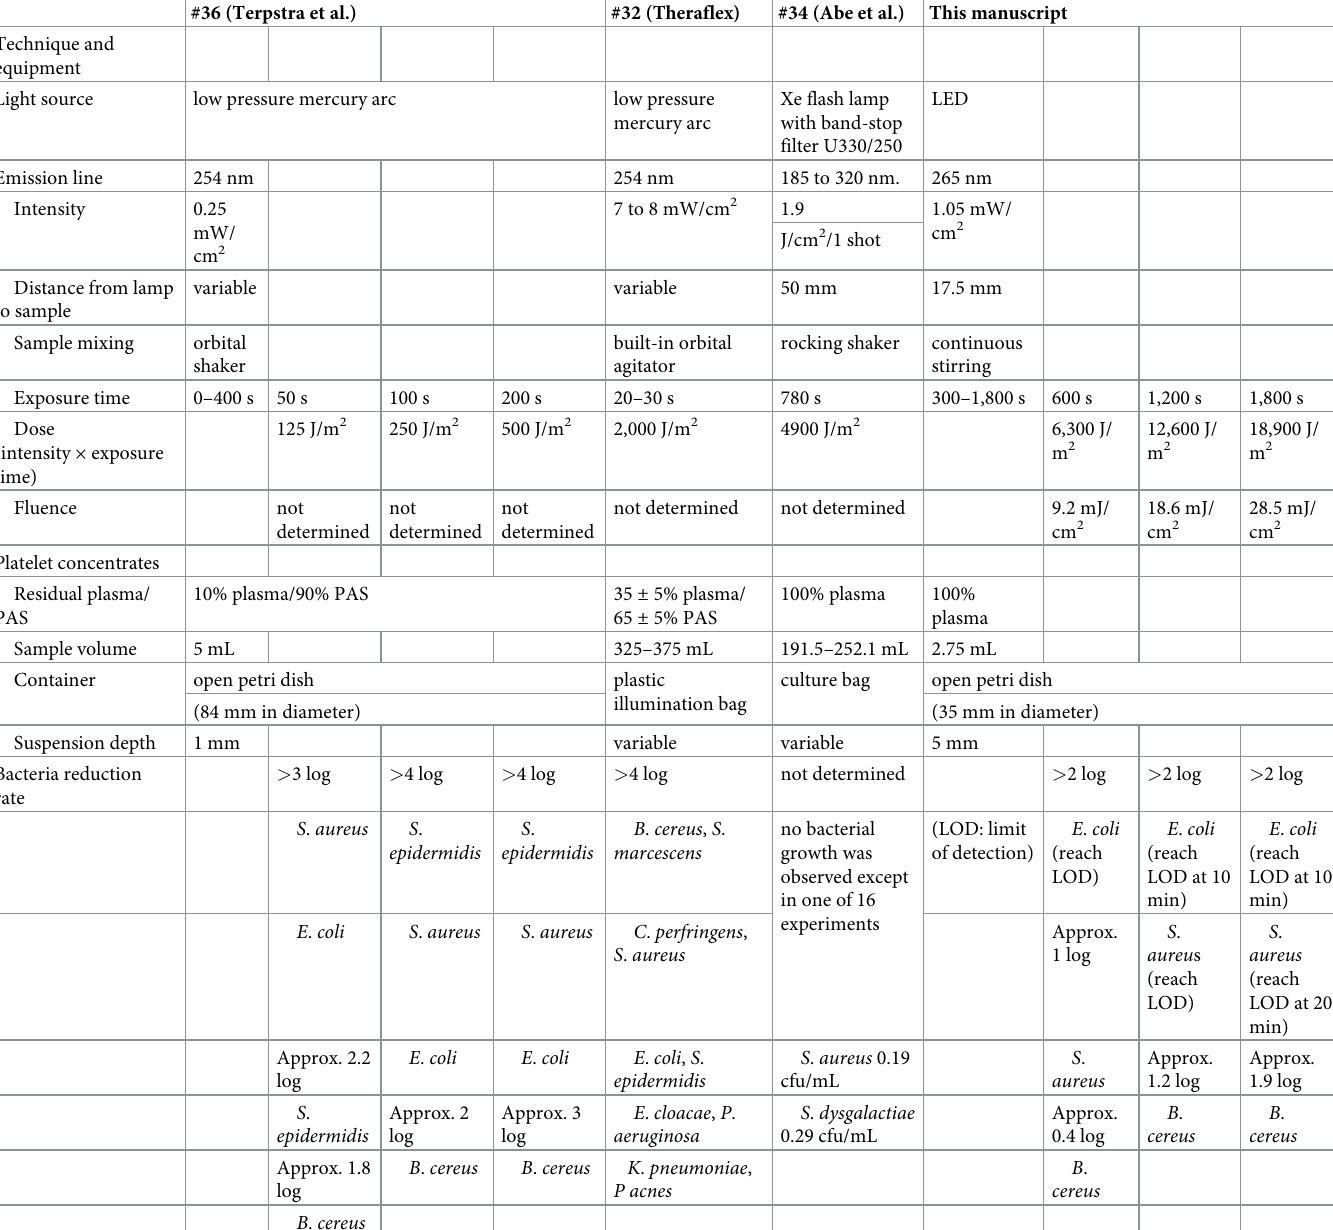
Table 2. Characteristics of UV irradiation techniques. Data extrapolated from reports. #36 (Terpstra et al.) #32